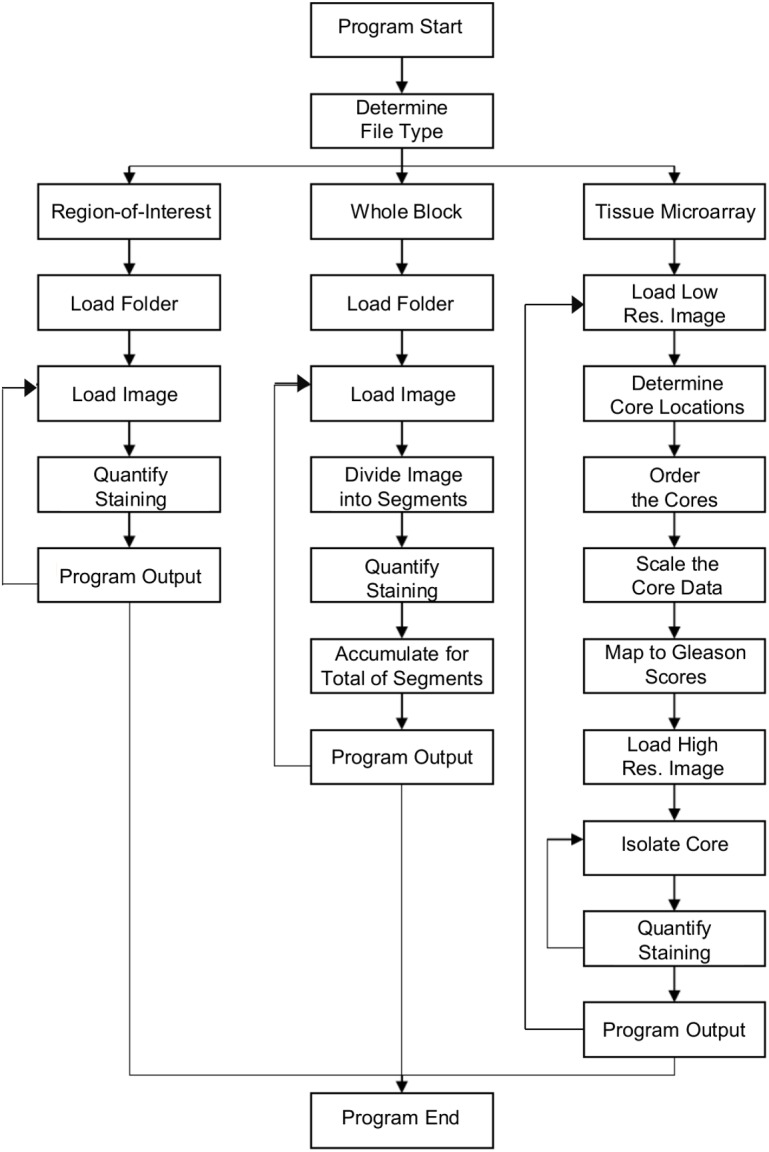
Overview of program workflow.